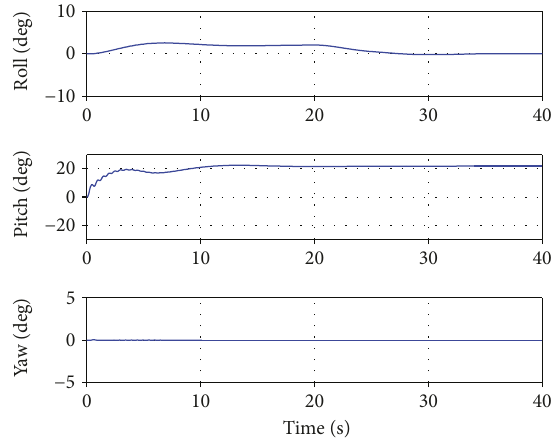
Figure 16: Weight value of the neural network in scenario